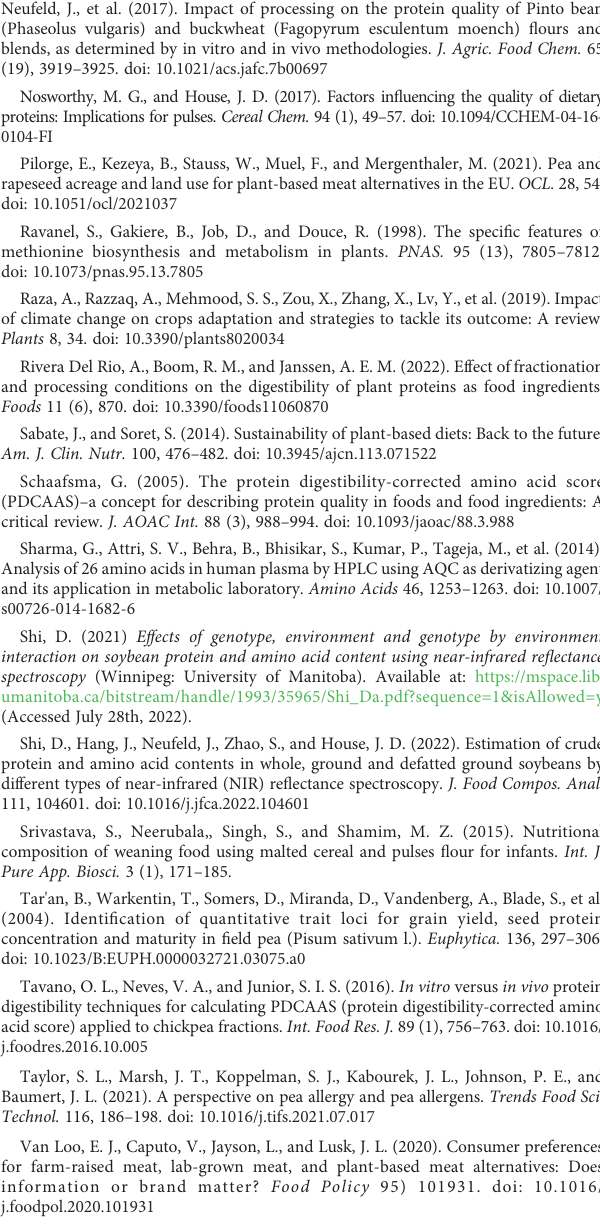
SUPPLEMENTARY FIGURE 3 Individual QTL analysis from each station-year in PR-25 reveals the QTLs associated for lysine concentration. Individual QTL analysis was based on average phenotypic data of biological replicates in each station-year. SUPPLEMENTARY FIGURE 4 Individual QTL analysis from each station-year in PR-25 reveals the QTLs associated for in vitro protein digestibility. Individual QTL analysis was based on average phenotypic data of biological replicates in each